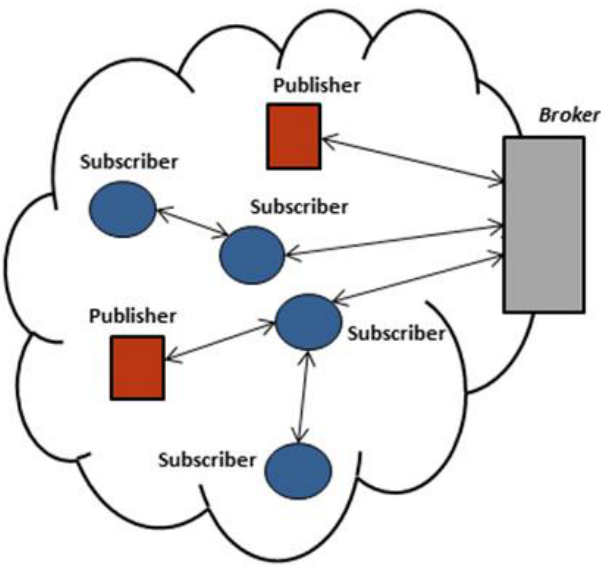
Figure 1. General MQTT-S